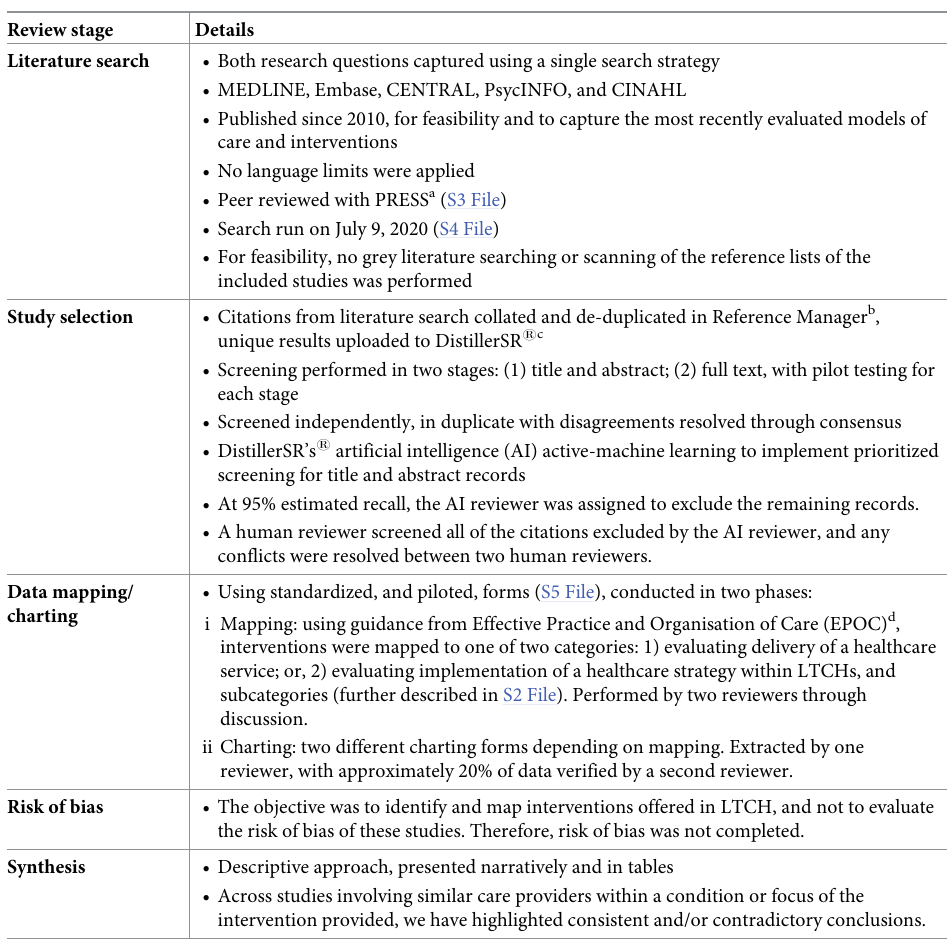
Table 2. Methods in